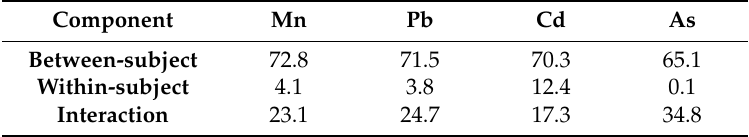
Table 3. Percent of variance in hair metal levels attributed to between-subject, within-subject (i.e., hair segment), and subject–segment interaction components according to interclass correlation